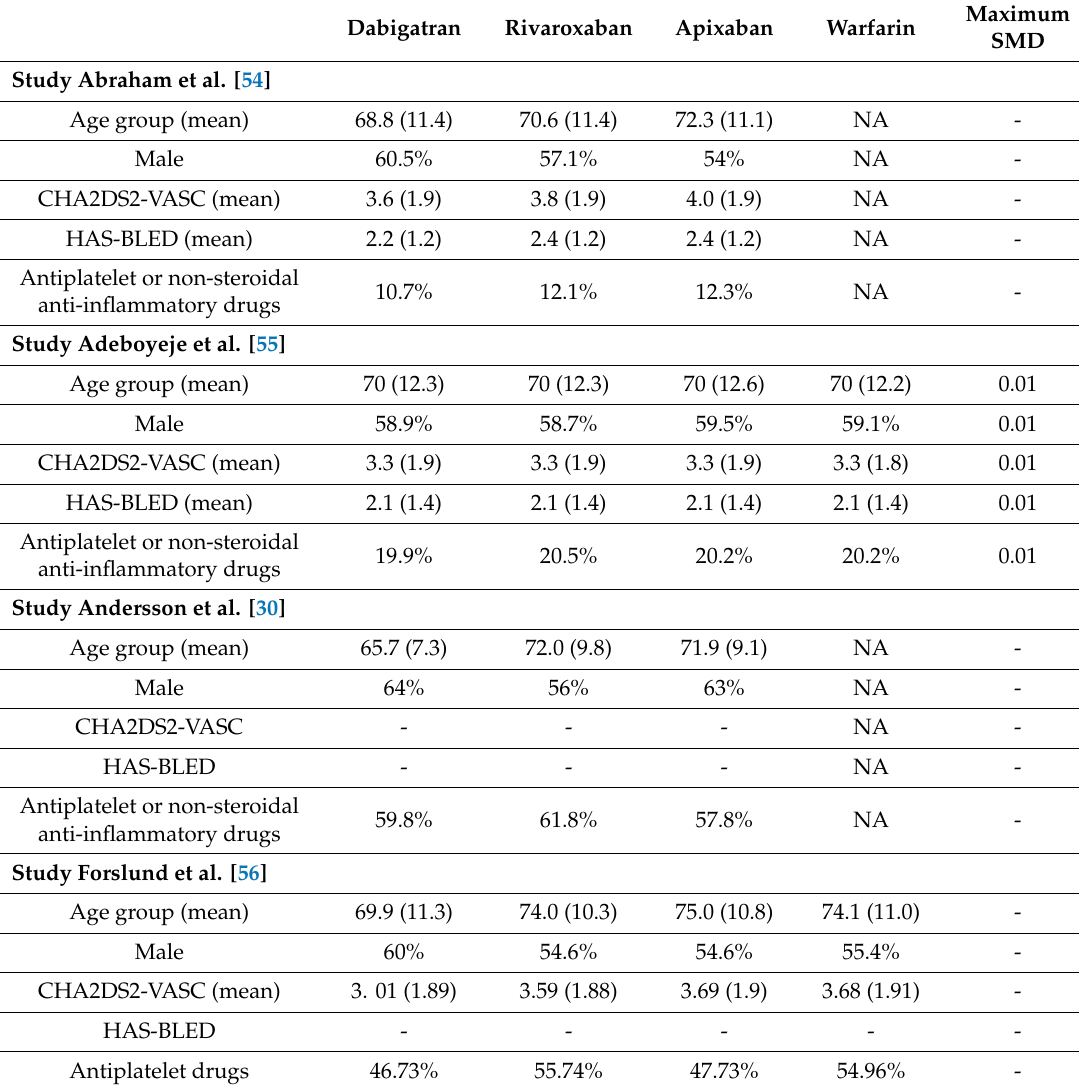
Table 4. Baseline characteristics of patients included in the studies. Dabigatran Rivaroxaban Apixaban